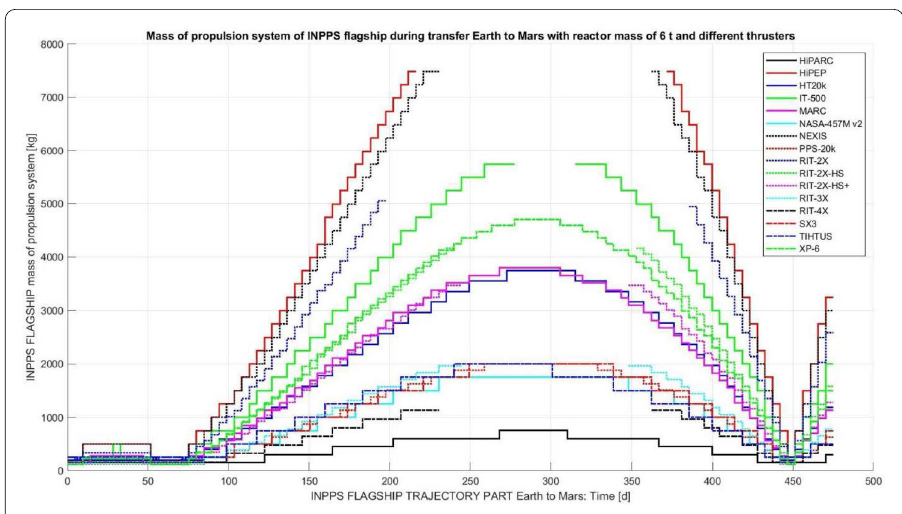
Figure 13 Plot of necessary PS mass to generate the required thrust including thruster, redundant PPU and PFS over mission time of trajectory Earth-Mars featuring relevant thruster types. Breaks show that